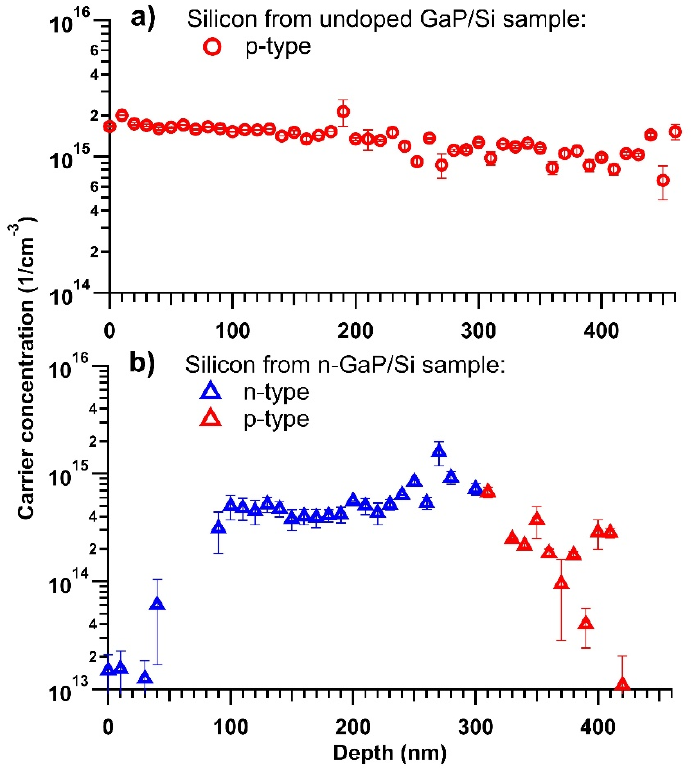
Figure 9. Electro-chemical capacitance voltage (ECV) of silicon substrates as a function of the depth, on which a GaP ( a ) or GaP:Te ( b ) were grown on top after the substrate preparation. These layers were etched for measuring the n-dopants diffusion into the silicon substrate.